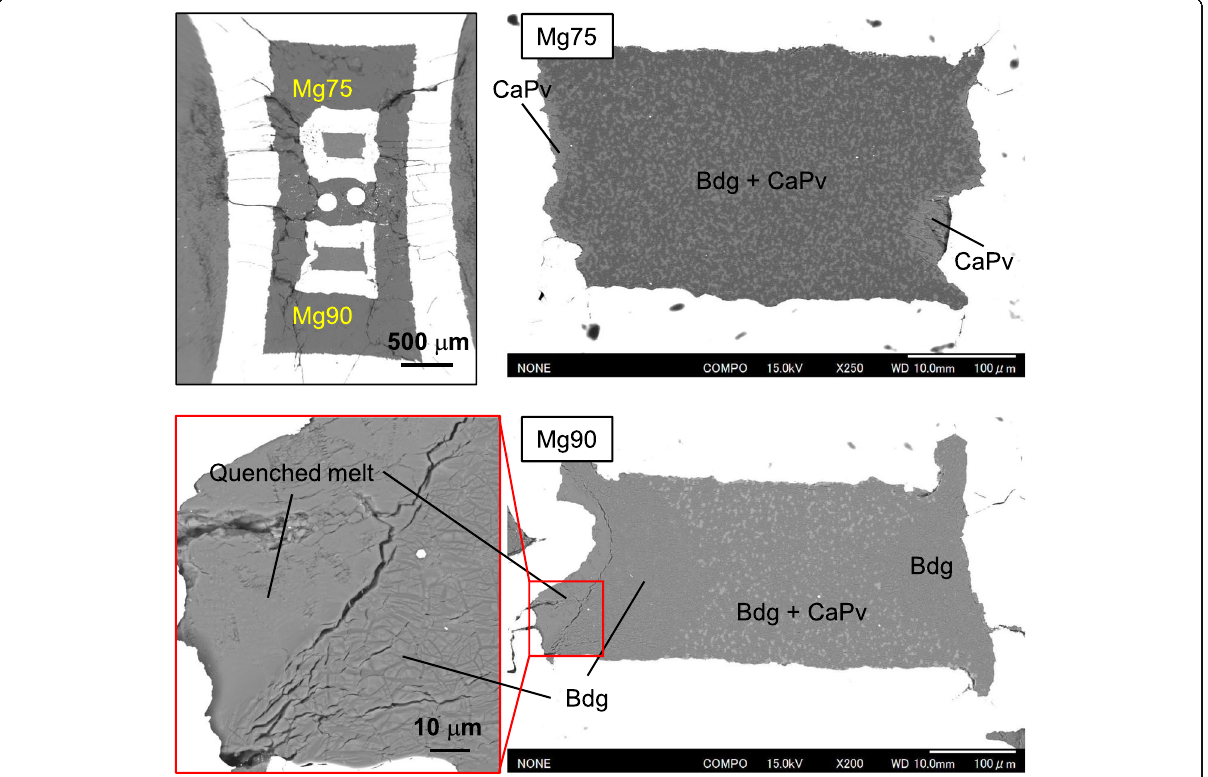
Fig. 4 Backscattered electron images for the samples recovered from high pressure and high temperature (Run No. OS3099). In Mg90, a quenched melt was found at the hottest region surrounded by bridgmanite (Bdg), which is interpreted as the liquidus phase. In contrast, CaSiO 3 -rich perovskite (CaPv) was found to be segregated in Mg75. We failed to find the melt. The subsolidus phase assemblage was observed at the central (cold) part of both